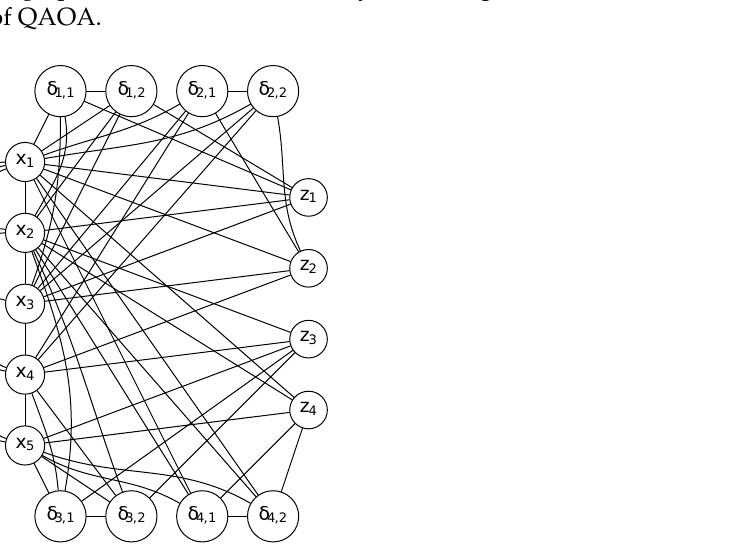
Figure 4. The derived graph for the dualization of the linear formulation of Example 1. The maximum degree of the graph is 13, the chromatic index of this graph is either 13 or 14, and the unitary circuit depth for one layer of QAOA is either 14 or